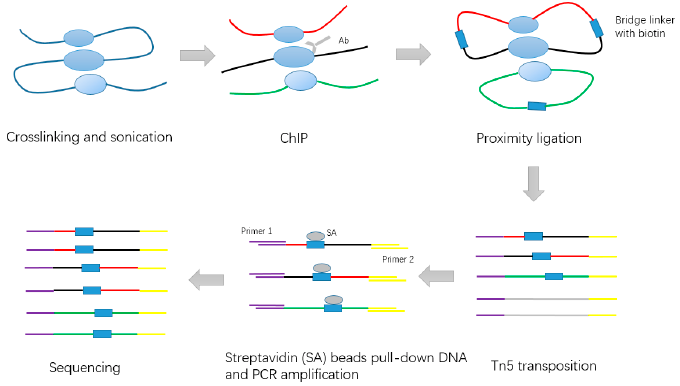
Figure 2. Schematic of long-read ChIA-PET experiment steps.